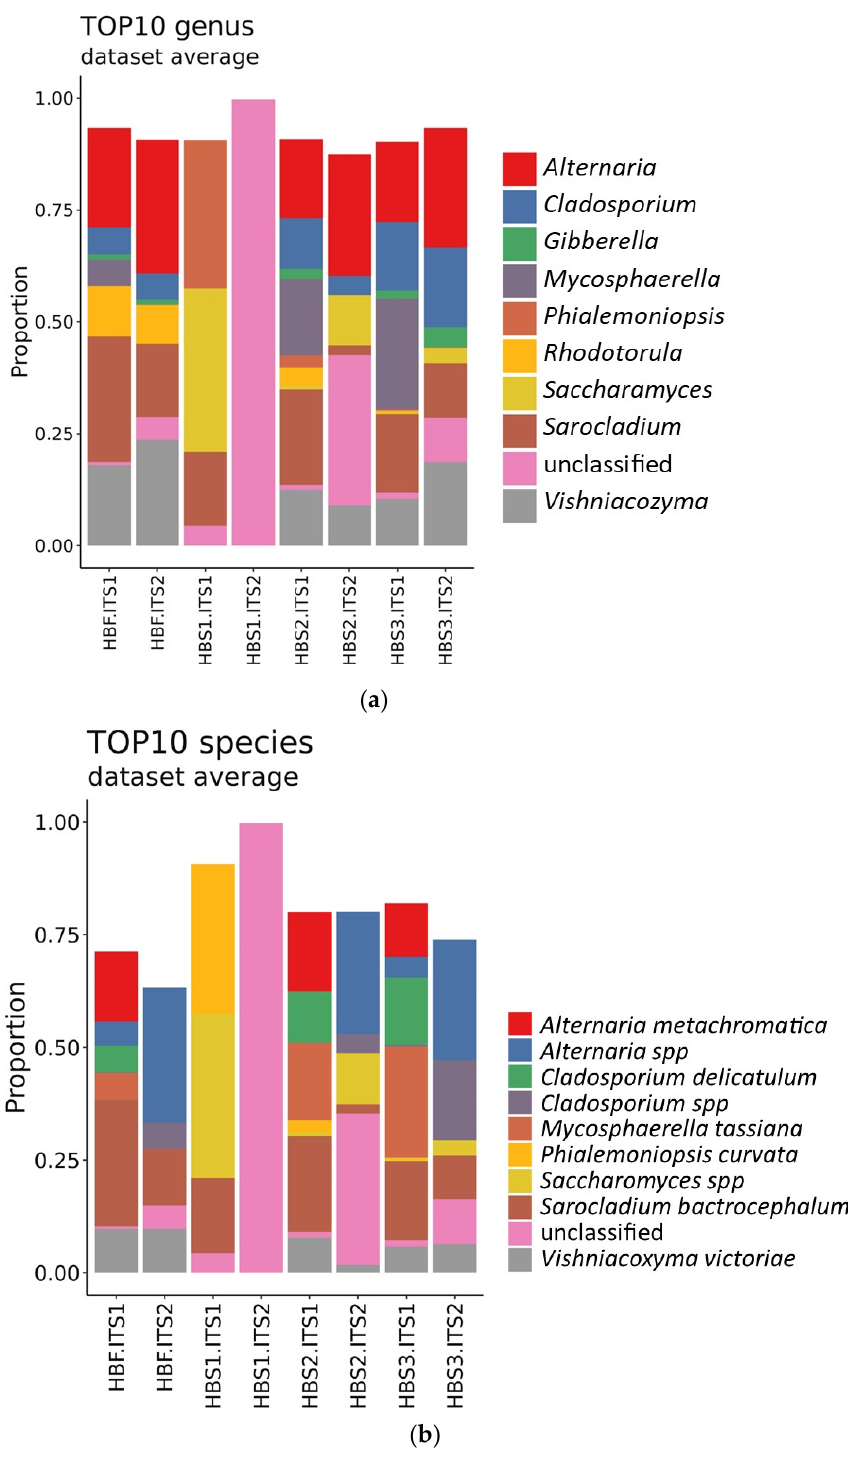
Figure 6. Taxonomic composition of the 10 most represented fungi genus ( a ) and species ( b ) for hull-less barley flour and in the sourdough after the 1st, HBS1.ITS1; HBS1.ITS2; 2nd, HBS2.ITS1; HBS2.ITS2, and the 3rd HBS3.ITS1; HBS3.ITS2 backslopping steps of fermentation.